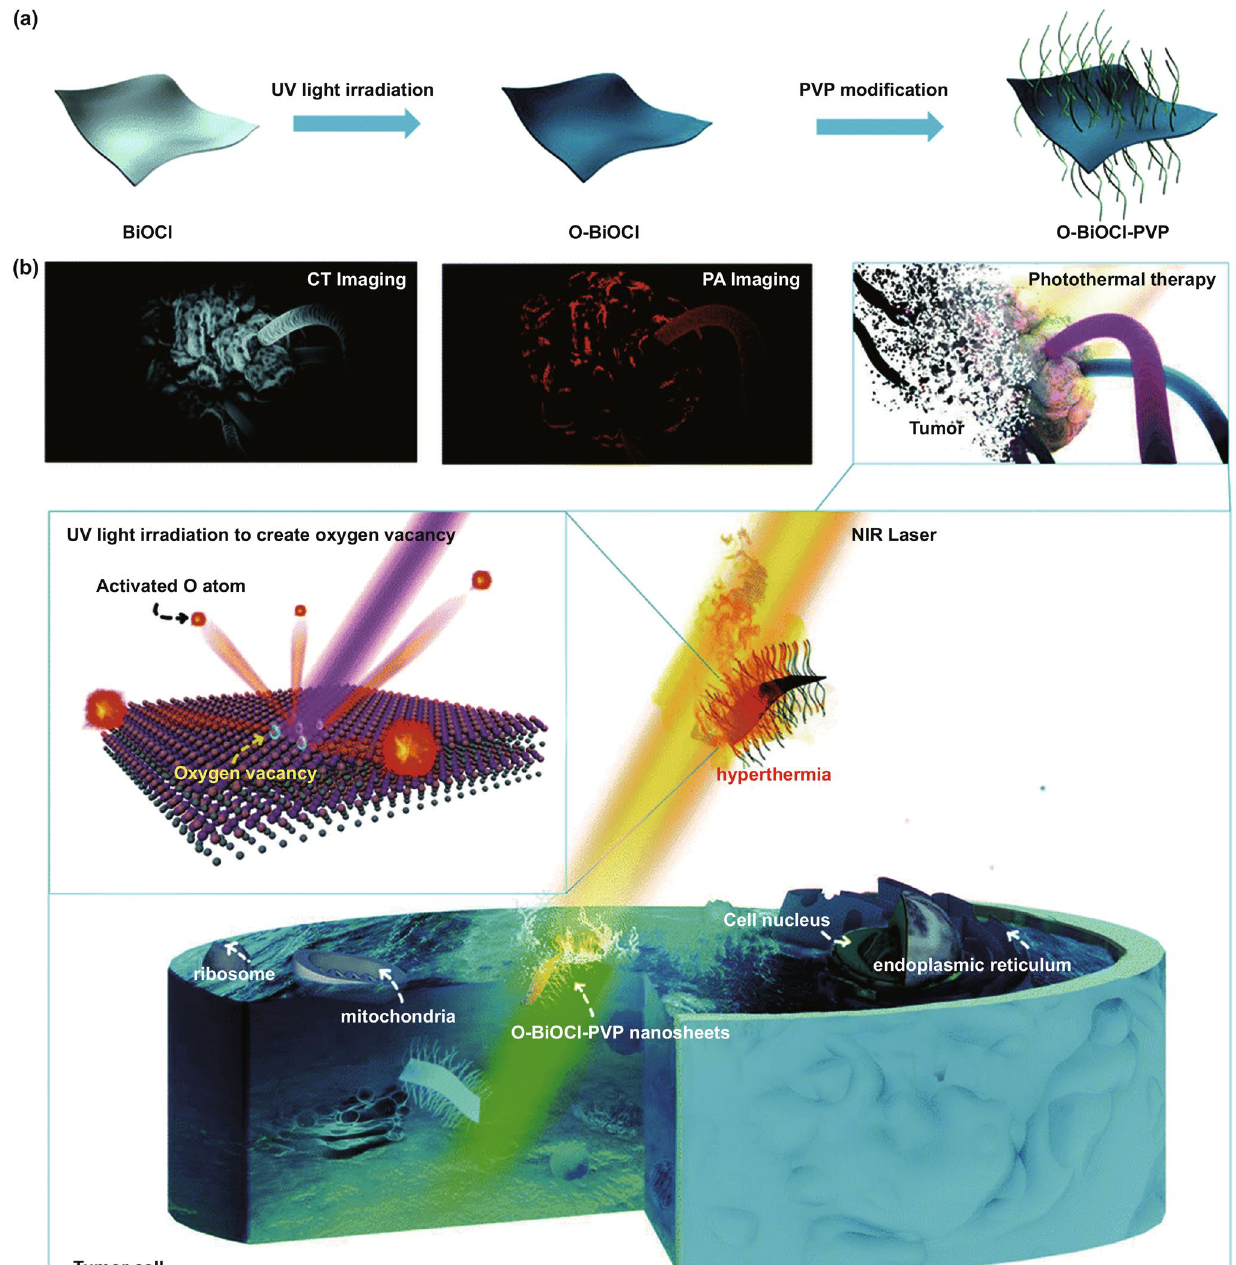
Fig. 12 2D BiOCl nanosheets for photonic tumor ablation with the combination of physiochemical properties and photocatalytic effect. Repro- duced with permission [364]. Copyright 2020, Royal Society of